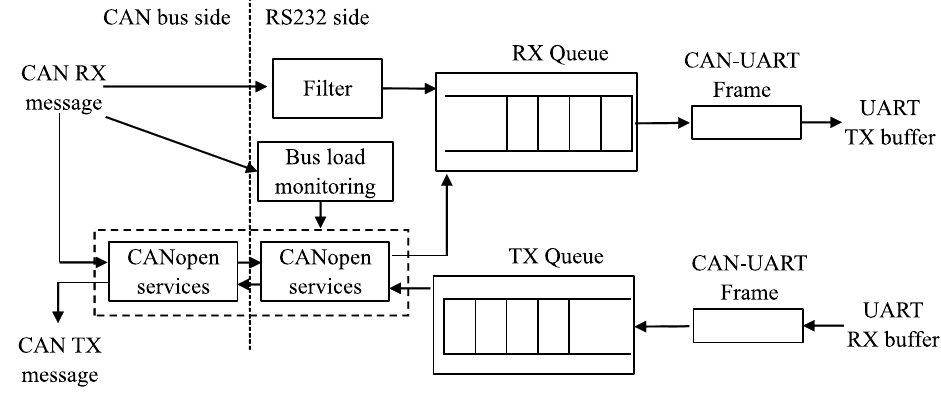
Figure 5. Data flows in DLL of the gateway.